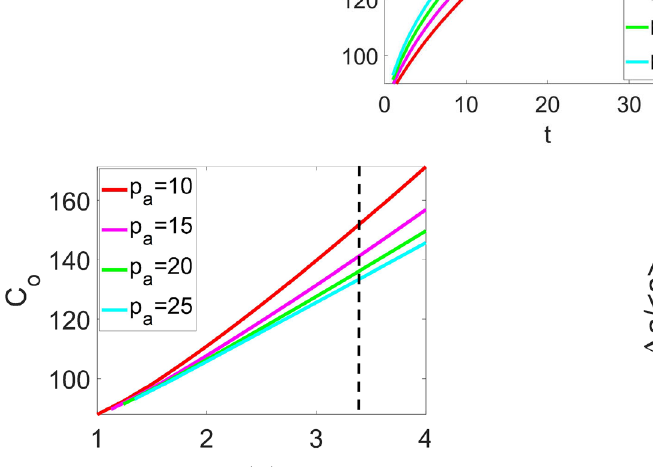
Fig. 5 Variationsinthe coherence versus theaverage value of the scale factor (cid:7) a (cid:2) . The horizontal and verticalaxes represent (cid:7) a (cid:2) and coherence, respectively. The parameters are taken as: α = 0 . 5, V 0 = 200